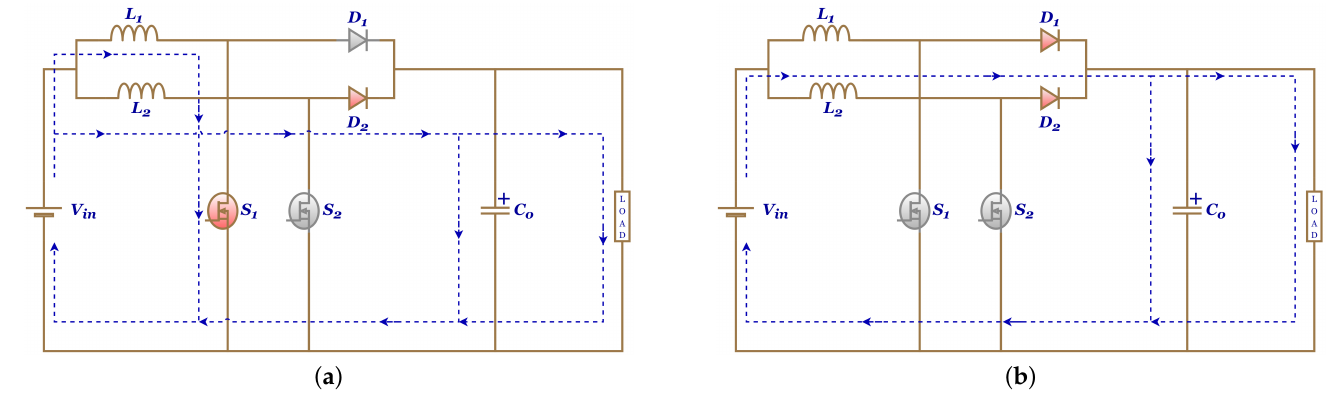
Figure 11. 2-IBC operation: ( a ) S 1 closed, and ( b ) all switches